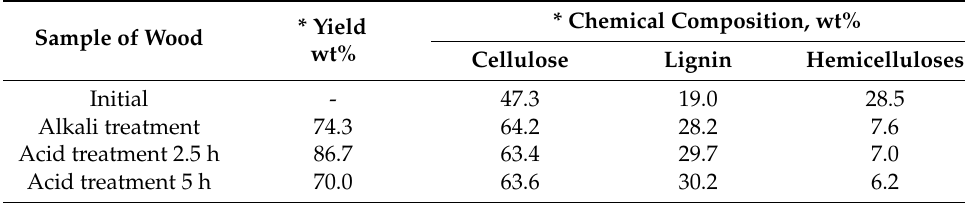
Table 1. Chemical analysis of processed and initial birch